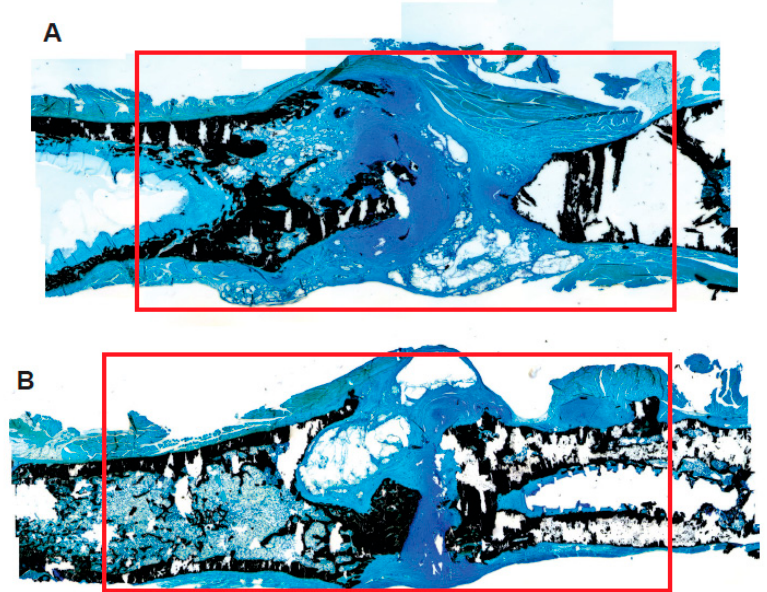
Figure 6. Histological analyses. Representative images showing the Von Kossa staining of the region of interest (ROl) for a rat treated with ( A ) acellular i.e., PLGA 50:75 scaffold alone, and ( B ) PLGA 50:75 + 1 million hAD-Mscs. The RO is shown as a red box. Note the black staining indicating new mineralized tissue in the defect. Note that the medullary cavity as visualized with the screw marks. is filled with new bone in ( B